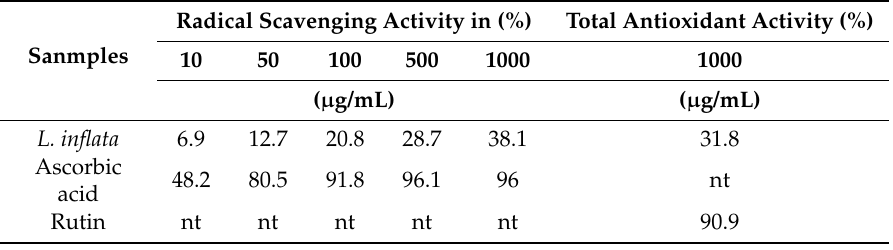
Table 3. Free radical scavenging activity and antioxidant activity of L. inflata essential